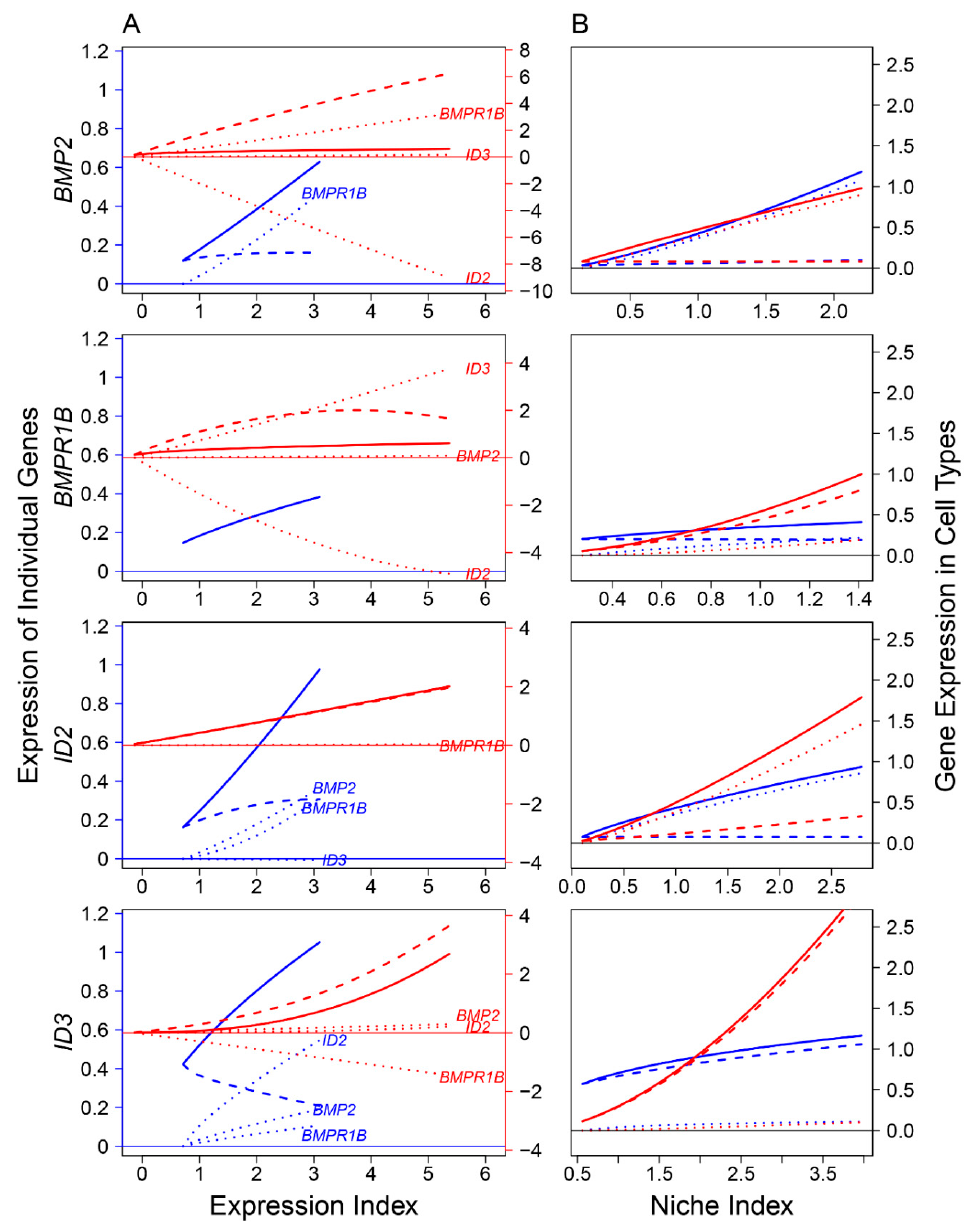
Figure 7. FGC–soma interactions driven by genes involved in the bone morphogenic protein (BMP) signaling pathway, where BMP2 is the ligand highly expressed in somas, BMPR1B is the receptor expressed in both somas and FGCs, and ID2 and ID3 are the targets specifically upregulated in RA-responsive, meiotic prophase, and oogenesis FGCs. ( A ) BMP2 , BMPR1B , ID2 , and ID3 worked together in a network to mediate FGC and soma development as a function of expression index, respectively. Left and right sides of the figure denote the expression levels of genes in FGCs (blue) and somas (red), respectively. ( B ) The niche index-varying pattern of interactions between FGCs (blue) and somas (red) driven by individual genes. Solid thick lines, slashed lines, and dotted lines denote the overall expression level, independent expression level, and dependent expression level,